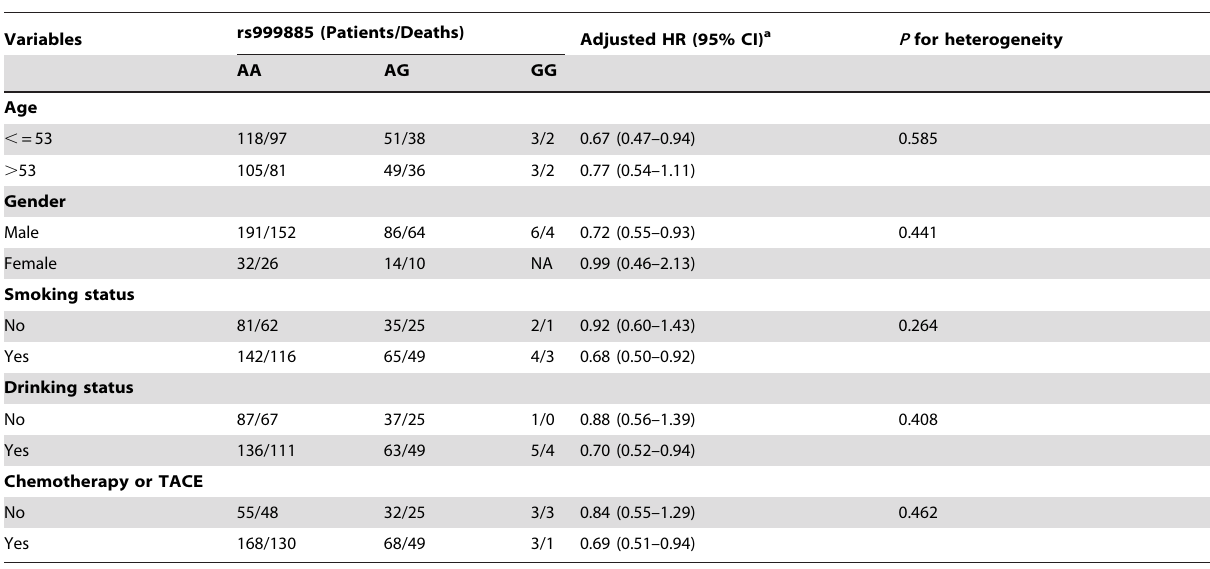
Table 2. Stratified analysis of rs999885 genotypes and HCC survival.